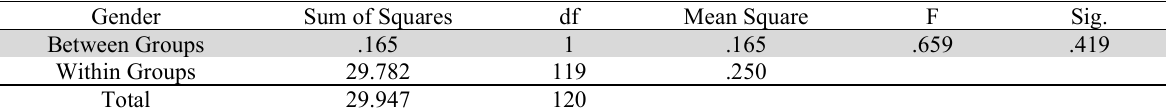
The results of ANOVA test for the effect of gender Gender Sum of Squares df Mean Square F Sig. Between Groups .165 1 .165 .419 Within Groups 29.782 119 .250 Total 29.947 120